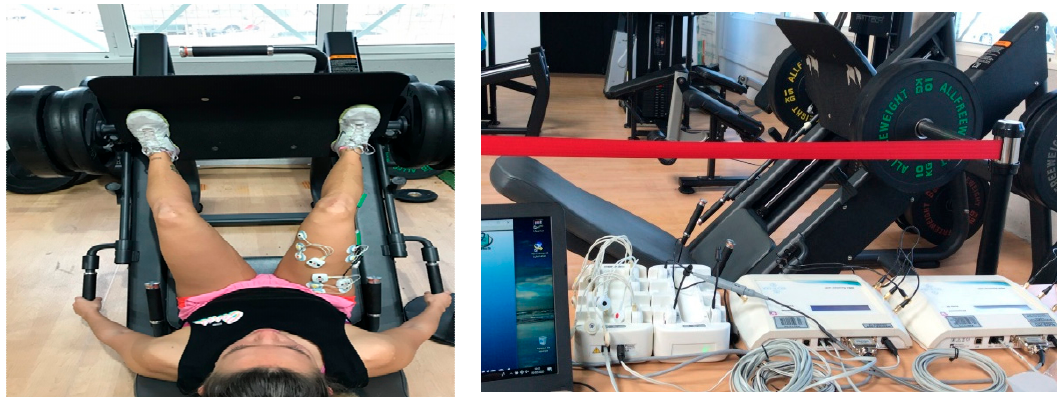
Figure 1. Experimental set-up.